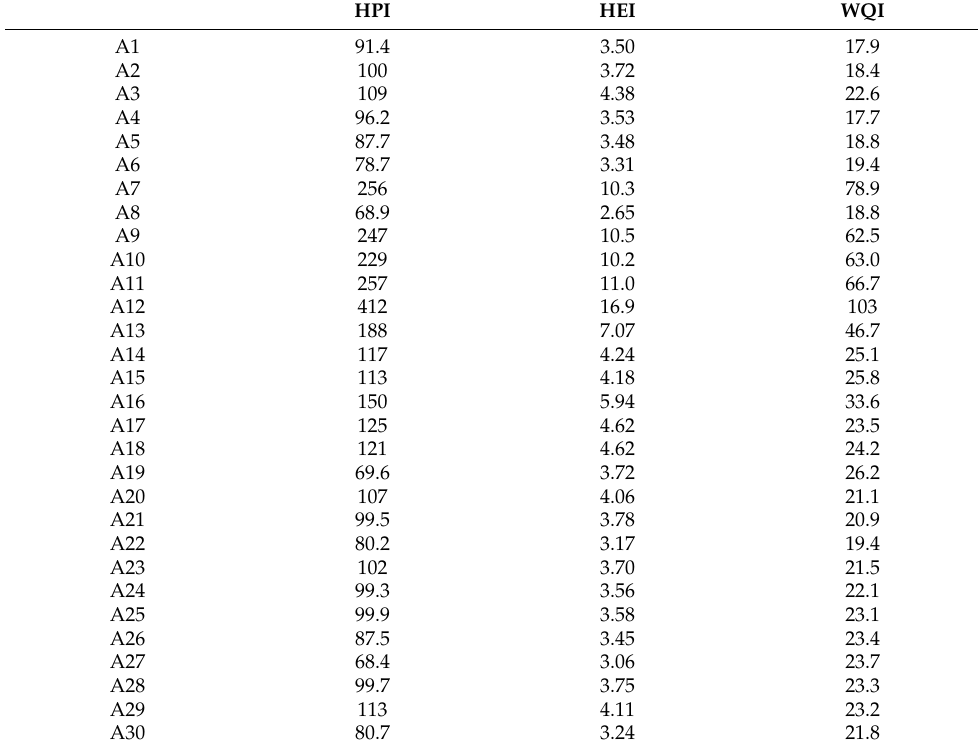
Table 5. Results of the calculated pollution and quality indices (HPI, HEI and